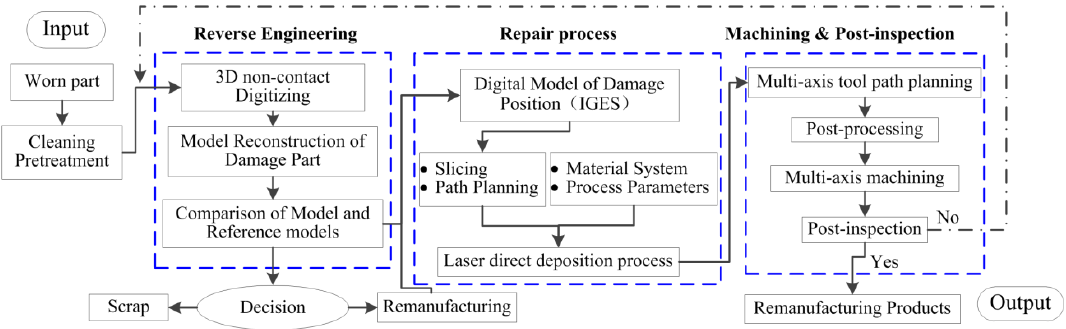
Figure 1. Overview of remanufacturing strategy.